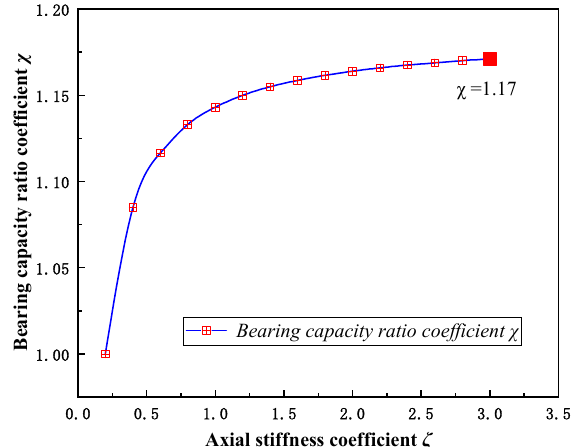
Figure 13. Bearing capacity variation coefficient curve.